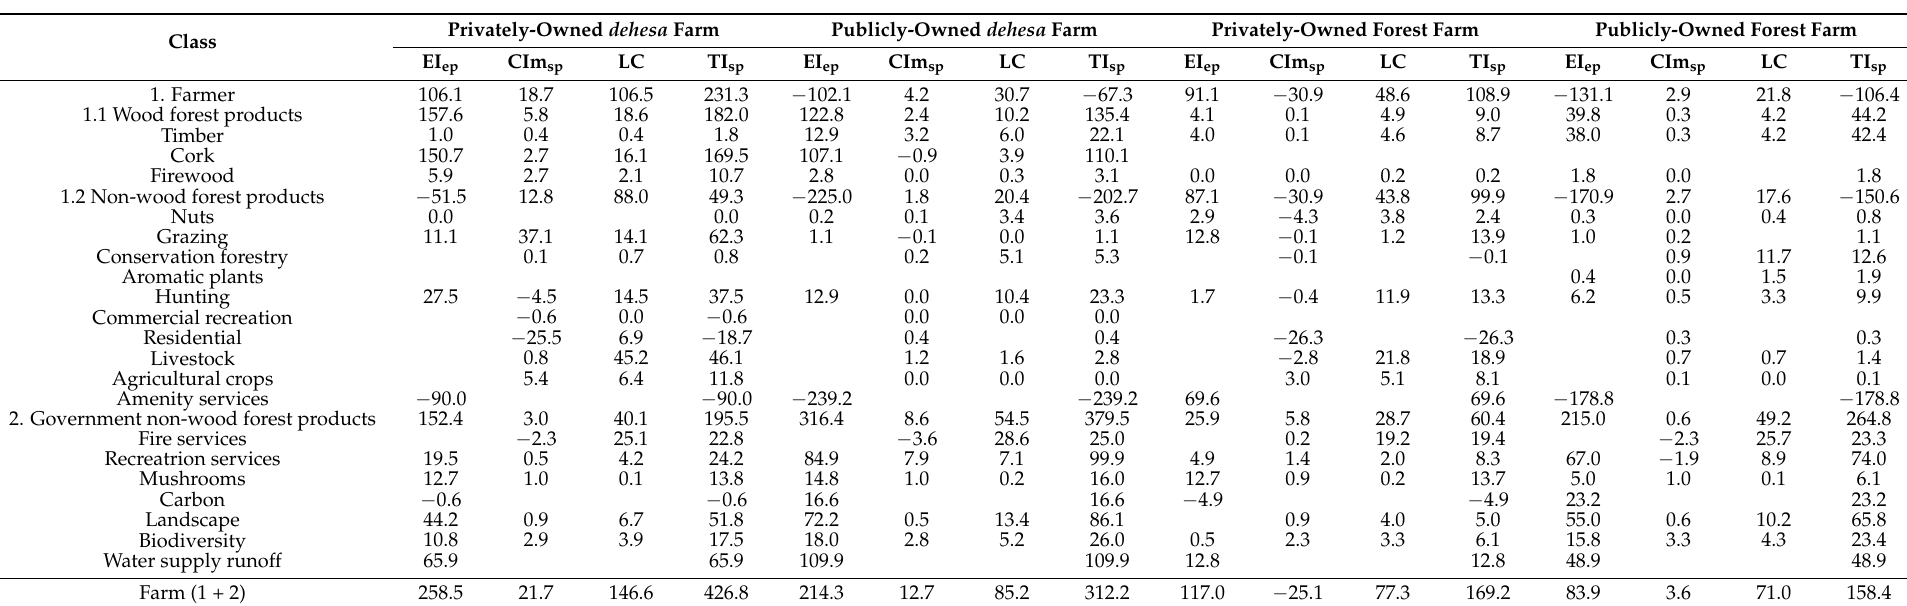
Table 6. Contribution of environmental income to total income of the case-study large dehesa and forest farms in Andalusia under the AAS (2010: € /ha).